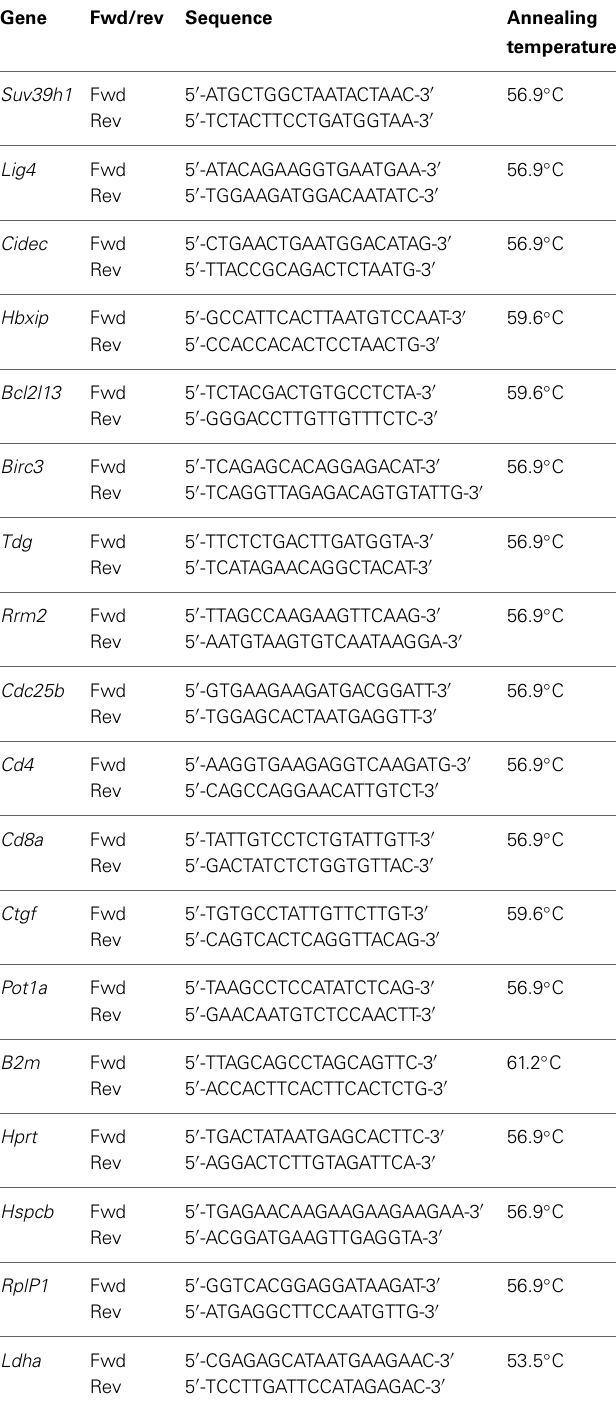
Table 4 | Primers used for qRT-PCR analysis of transcript levels. Gene Fwd/rev